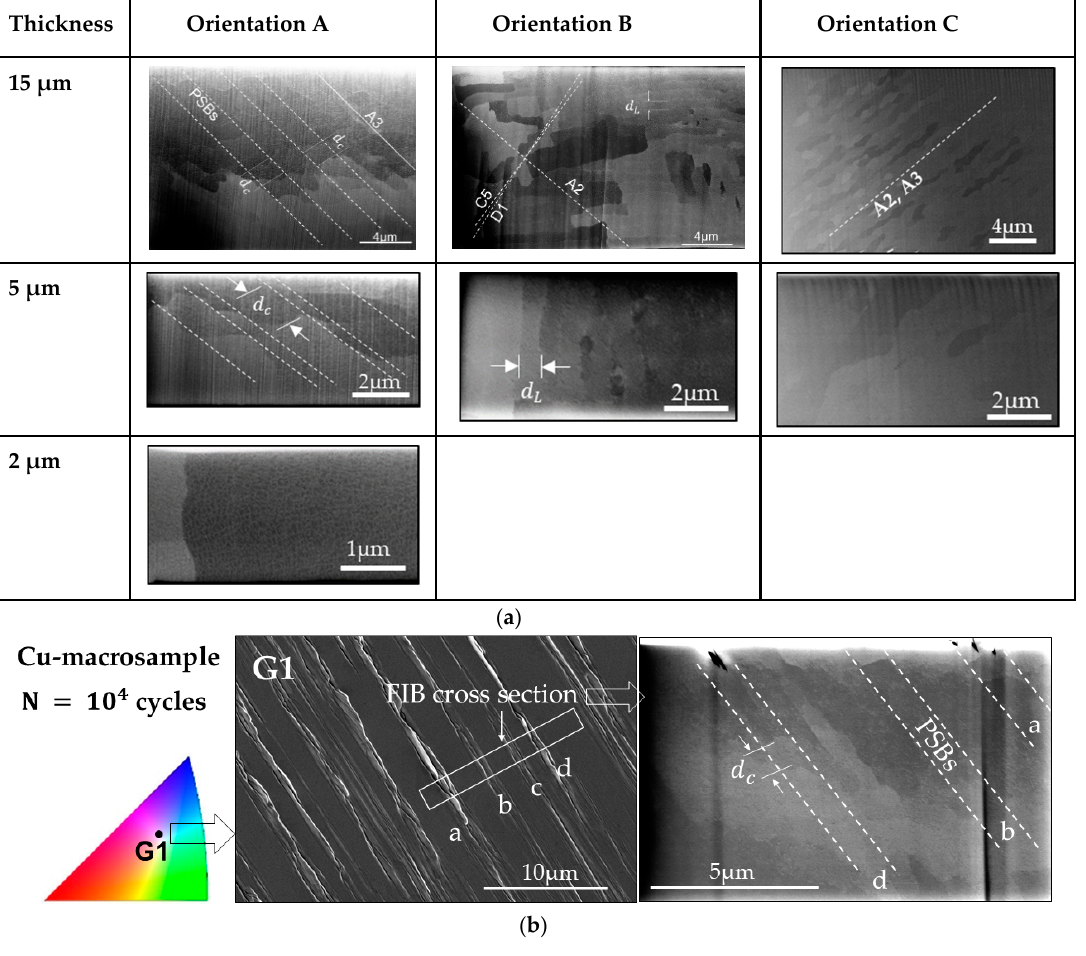
Figure 7. ( a ) Back-scattered electrons (BSE) images with the characteristic dimension of PSB-ladder and labyrinth structures, the PSB wall spacing d c and labyrinth spacing d L after 10 4 cycles of microbeams with the dimension of 15, 5, and 2 µm (W15, W5, and W2) with the orientation A, B, and C (this image was taken on the side surface of the beams (surface 2 in Figure 1b)). ( b ) In addition, a SE image of the tongue-like extrusions / intrusions of a grain oriented for single slip in a polycrystalline Cu macrosample after N = 10 4 cycles fatigued with a strain amplitude of ∆ ε pl ≈ 0.2 % and a BSE image of a cross-section with four PSBs (a, b, c, and d) revealing ladder-like